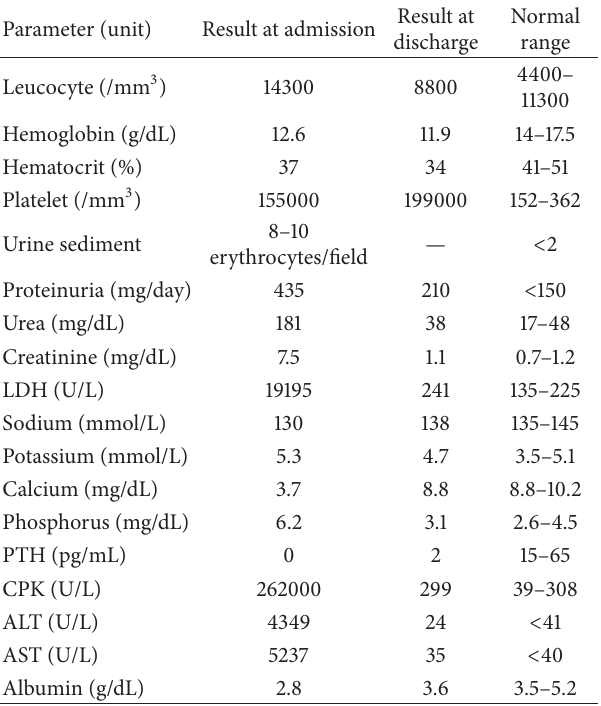
Table 1: Laboratory data of the patient at admission and at discharge.